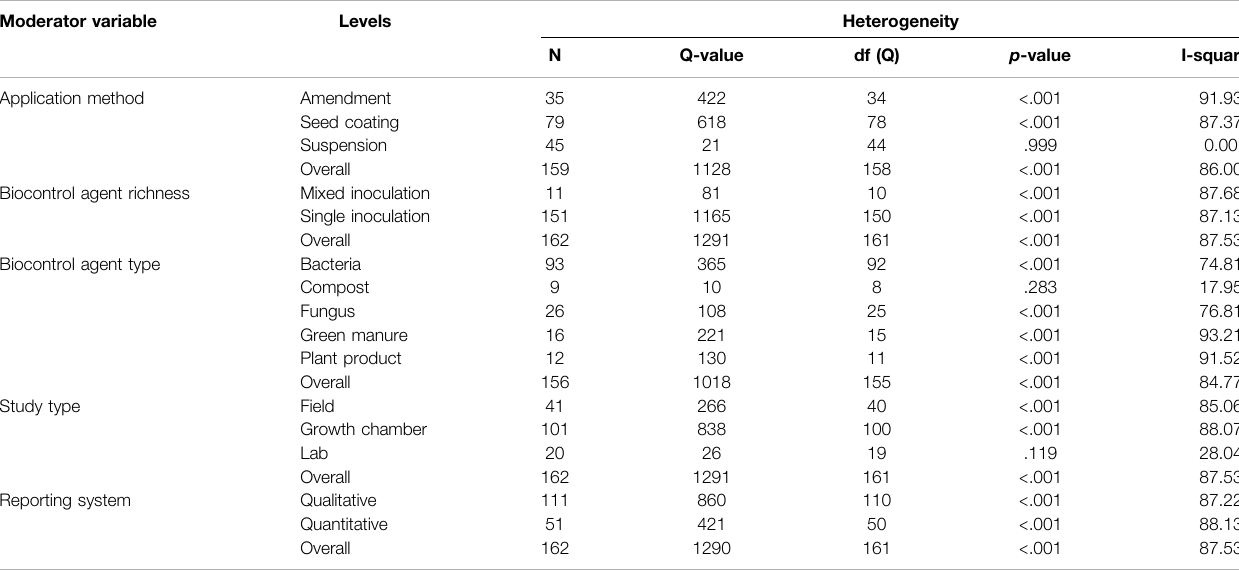
TABLE 1 | Measures used to quantify dispersion across effect sizes in each moderator variable.